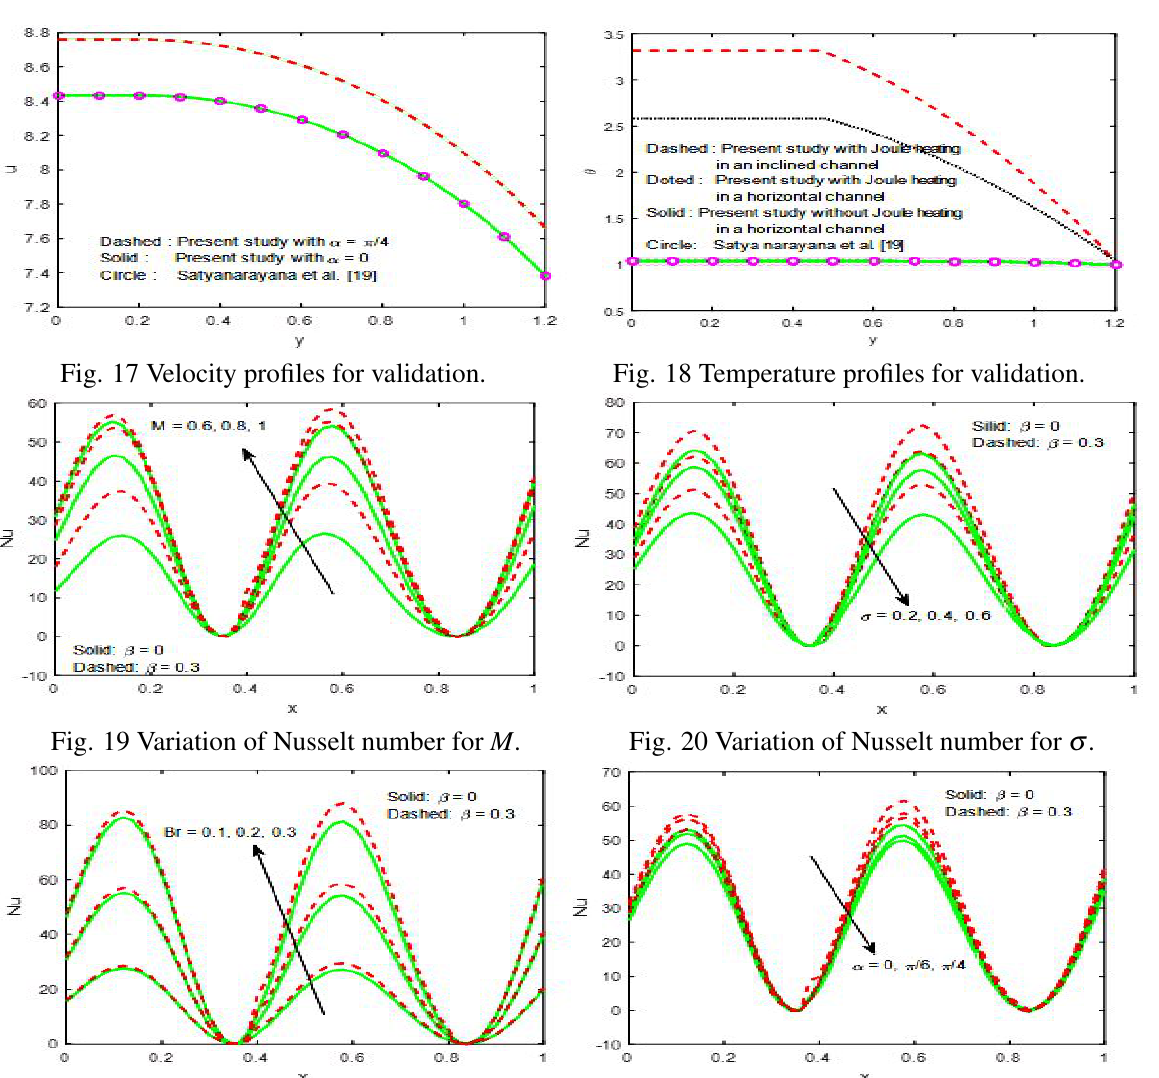
Fig. 21 Variation of Nusselt number for Br . Fig. 22 Variation of Nusselt number for α